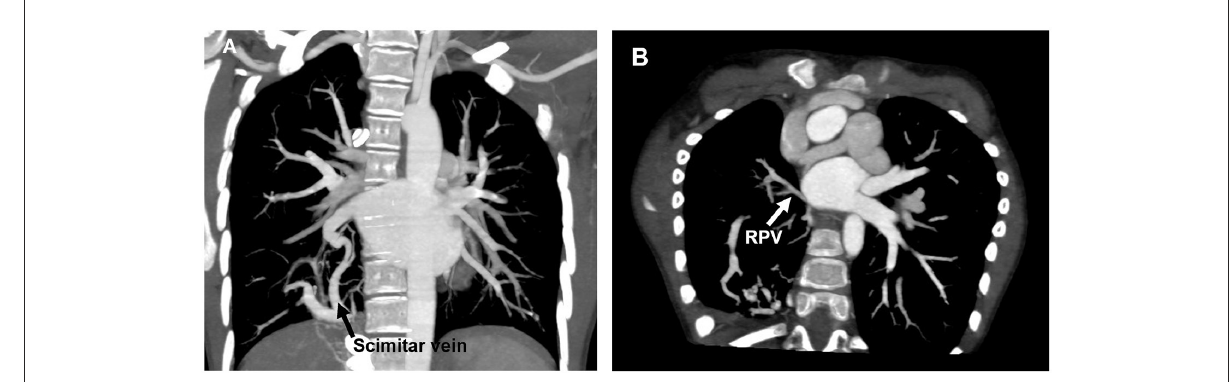
FIGURE1 CT scan showing anomalous pulmonary venous drainage of the right lung to the IVC (A) and restenosis of RPV after operation (B). CT, Computed tomography; IVC, Inferior vena cava; RPV, Right pulmonary